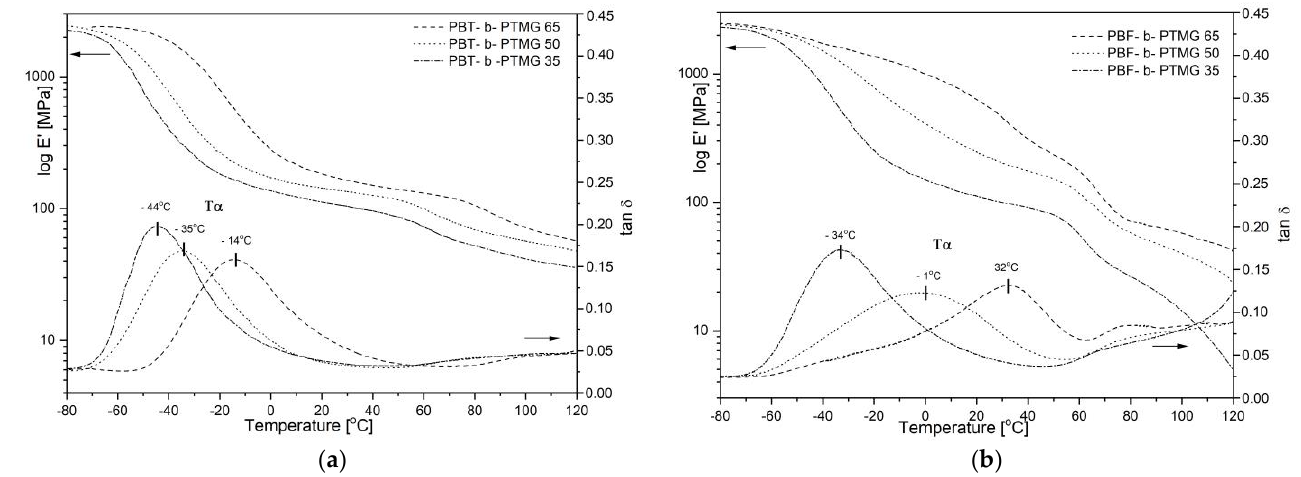
Figure 6. The storage modulus E’ and tan δ profiles for ( a ) PBT-b-PTMG and ( b ) PBF-b-PTMG co- polymers.